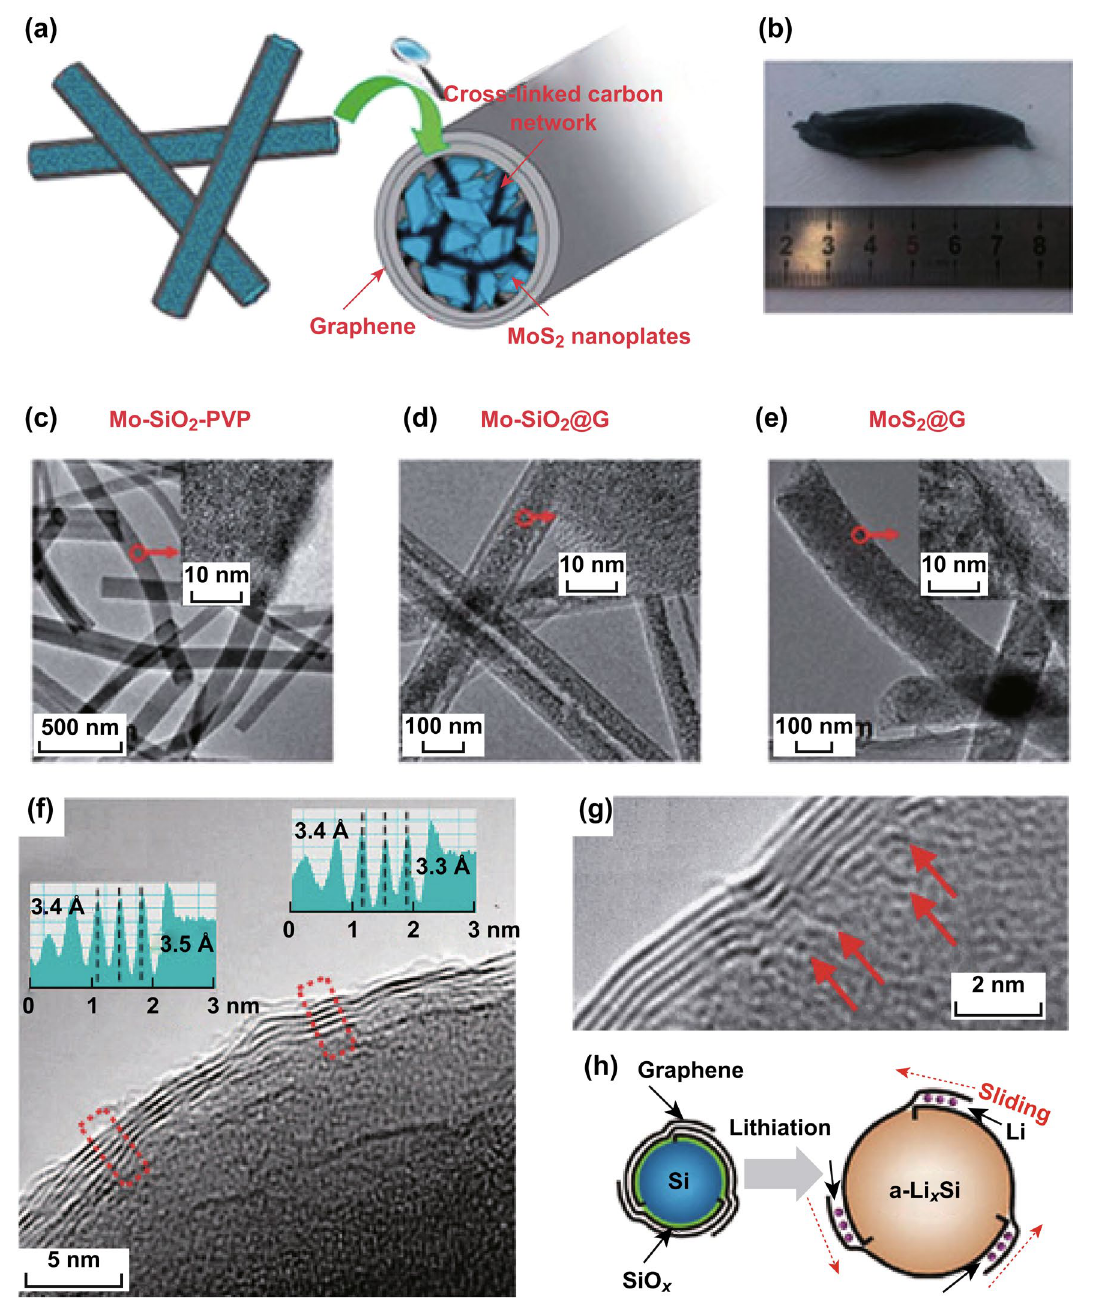
Fig. 4 a Schematic of MoS 2 @G. b Free‑standing MoS 2 @G membrane. SEM images of c Mo‑SiO 2 ‑PVP, d Mo‑SiO 2 @G, and e MoS 2 @G. Reprinted with permission from Ref. [87]. f HRTEM image of Gr‑Si NP. g HRTEM image visualizing the origins (red arrows) of individual graphene‑layer growth. h Schematic illustration showing the sliding of graphene coating layers that buffer the volume expansion of Si. Reprinted with permission from Ref.